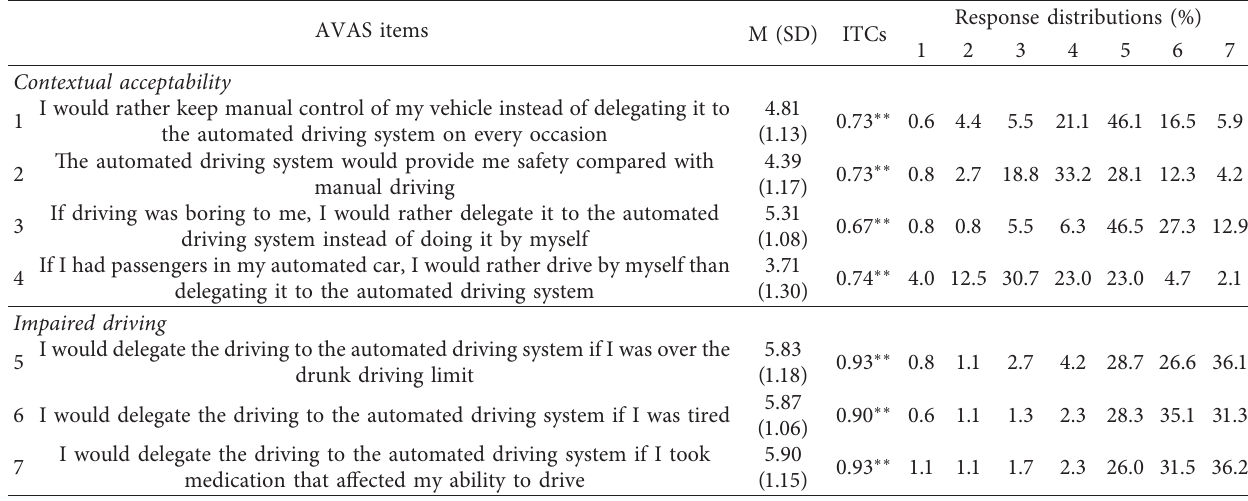
Table 2: Response means, standard deviations, and distributions.